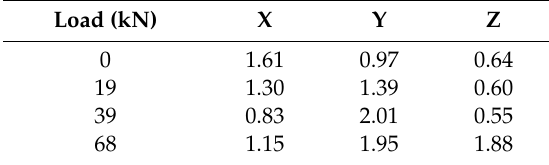
Table 14. Residuals (mm) on the GCPs beam#2 EOS